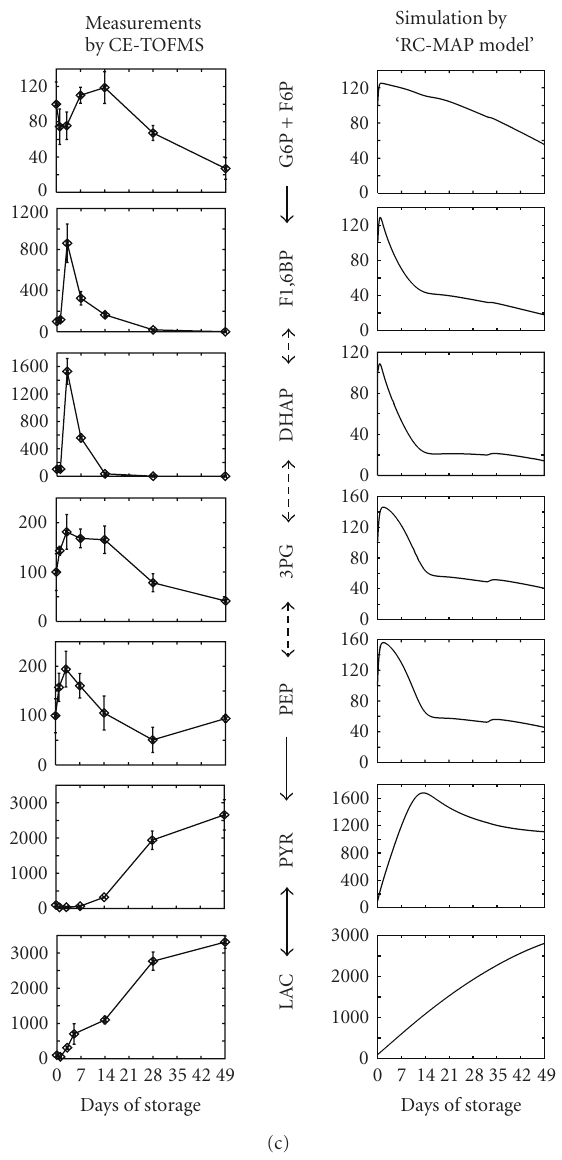
Figure 4: Modeling of metabolism in RBCs during long-term cold storage and model verification. (a) The work flow of developing and analyzing the “RC-MAP model”. (1) The values of external parameters in our E-Cell RBC model (basal model), which assumes normal circulating conditions, are modified to meet the conditions of the cold-MAP solution. (2) Adjustable parameters, which are thought to be changed by storage conditions, are determined. (3) Adjustable parameters are estimated using experimental data on metabolic alterations in RC-MAP. (4) The relevance and robustness of the parameter choices are checked. (5) The dynamics of metabolism are compared between the RC-MAP simulation and experimental treatment. (6) A sensitivity analysis of the model is conducted to find key reactions, metabolites, and parameters to maintain the energetics and oxygen-carrying capacity of stored RBCs. (7) Candidate components for optimized storage conditions are determined by computationally testing various combinations of factors that can be modified experimentally. (8) Finally, the candidate models are validated by a metabolome analysis. In (3), we employed the classical read number genetic algorithm within the E-Cell Simulation Environment to fit the model to the reported time-course data of ATP and 2,3-BPG concentration changes in RBCs held in cold RC-MAP for 49 days. (b) A comparison of time-related changes in ATP and 2,3-BPG levels between reported experiments (Shiba et al., 1991) and the “RC-MAP model” is presented. The time-course of ATP (solid black) and 2,3-BPG (broken black) in RC-MAP at 4 ◦ C for 49 days in (a) previously reported data and (b) the prediction of the estimated model derived by the Genetic Algorithm. Experimental values are shown as the mean ± S.D. of 19 separate experiments. Values are percentages of the initial concentrations. (c) Measured (left) and simulated (right) time-dependent alterations in glycolytic intermediates. In CE-TOFMS measurements, the RBC samples were suspended in cold-MAP for 49 days under laboratory conditions. Data represent the means ± S.D. of five separate experiments. “G6P + F6P” indicates the sum of the concentrations of G6P and F6P. Values are represented as percentages of the initial concentration of each